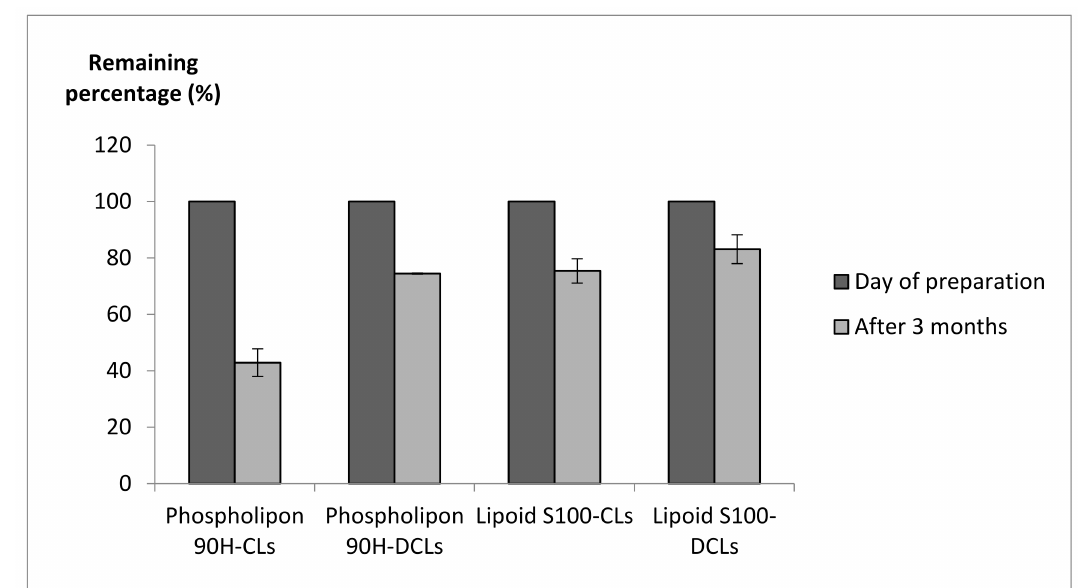
Figure 5. The percentage of remaining α -pinene determined on the day of preparation and after 3 months of storage at 4 ◦